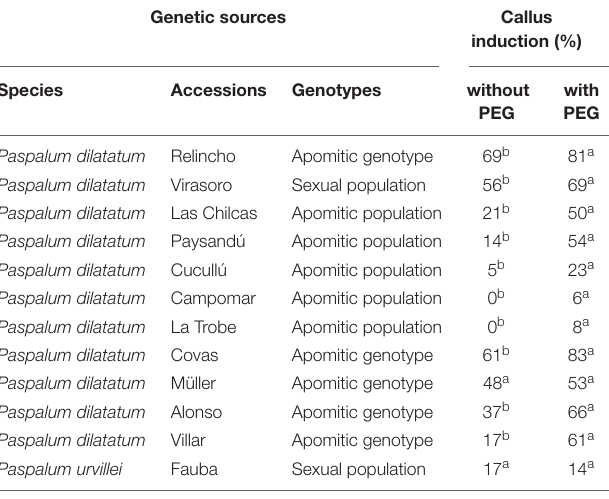
Different letters indicate significant differences within rows, G-test, (p < 0.05). Source: Schrauf, 2009. TABLE 2 | Efficiency of induction (number of induced calli/number of explants), proliferation (number of proliferated calli/number of induced calli) and regeneration (number of regenerated calli/number of proliferated calli) of explants from the Relincho genotype and its regenerants (R1). Material Different letters indicate significant differences, G-test, (p < 0.05). Source: Schrauf,